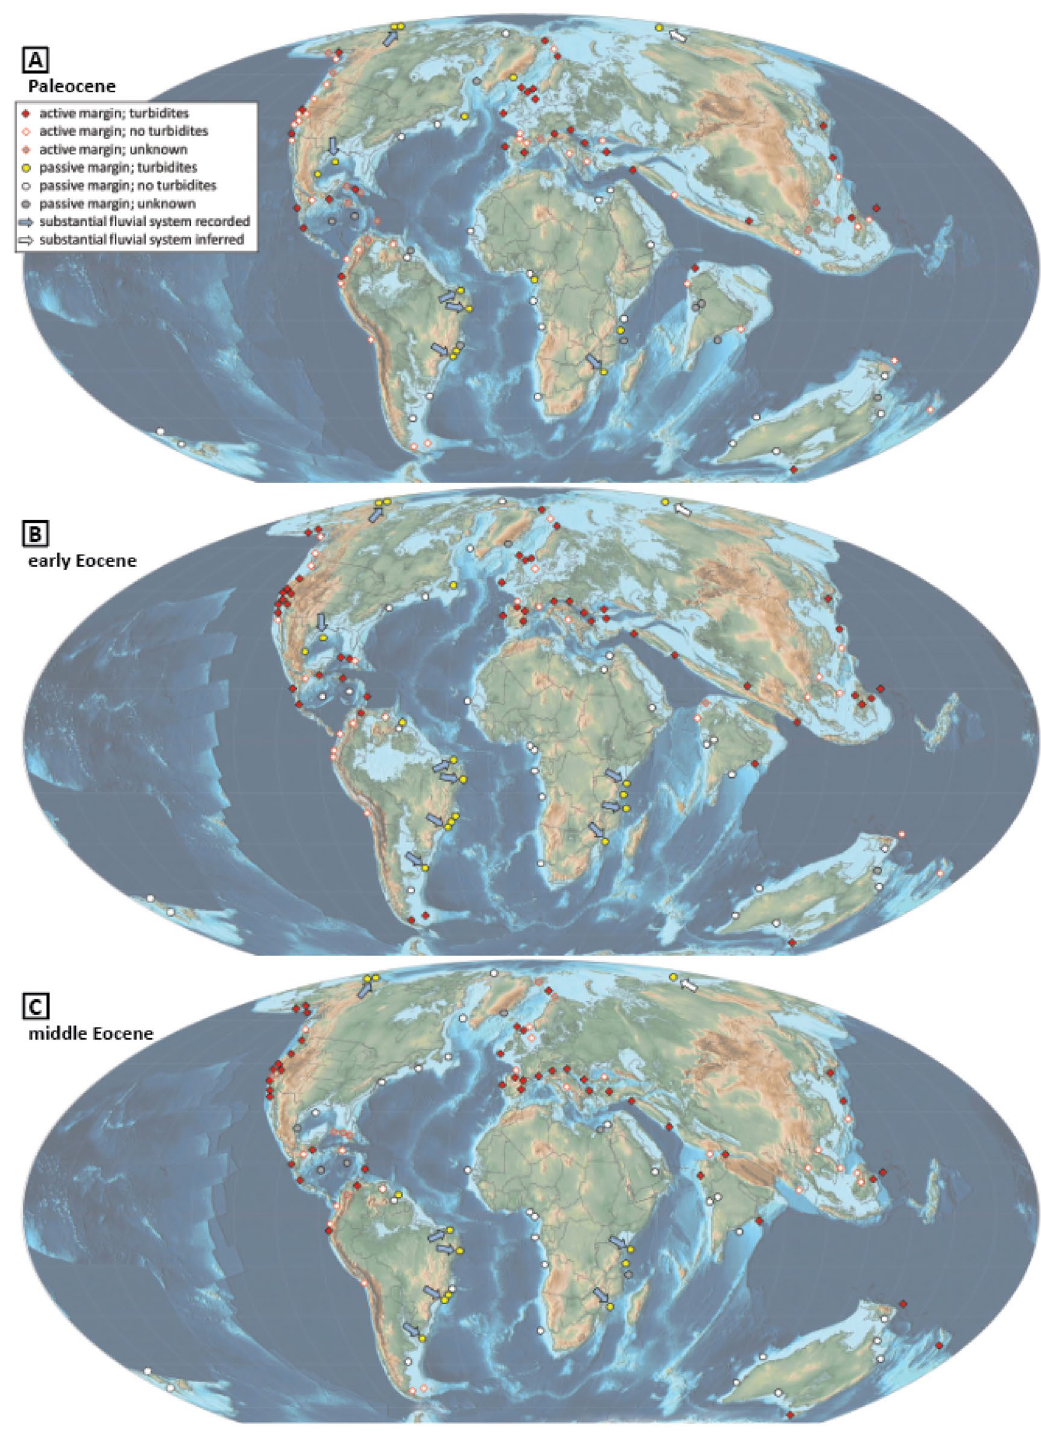
Figure 2. ( A ) Paleocene, ( B ) early Eocene, and ( C ) middle Eocene locations studied, including locations with and without recorded sand-rich deep-sea systems. Paleomaps are modified from the PALEOMAP Project of C. R. Scotese 35 . Location names and references are available in Supplementary